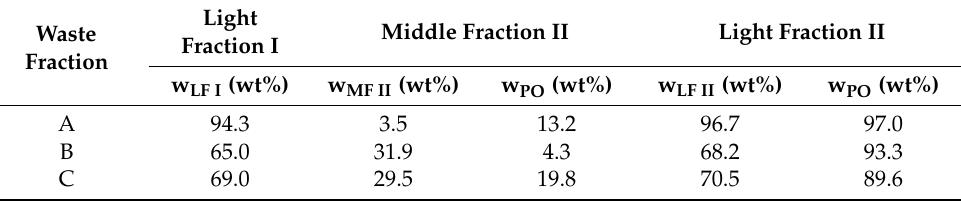
Table 14. Mass fraction of the first light fraction (w LF I ), second middle (w MF II ) and second light fraction (w LF II ) and corresponding polyolefin fraction(w PO ) of the second CFS for feedstocks with high (A), middle (B), and low (C) initial polyolefin